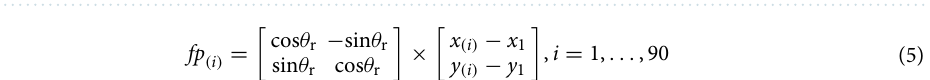
Figure 3. Example of displacements with velocities of 1 m/s at initial instant and future positions at three- seconds time window with accelerations from 0 to 1 m/s 2 (A) , from 3 to 4 m/s 2 (B) , and negative accelerations from 3 to 4 m/s 2 (C)